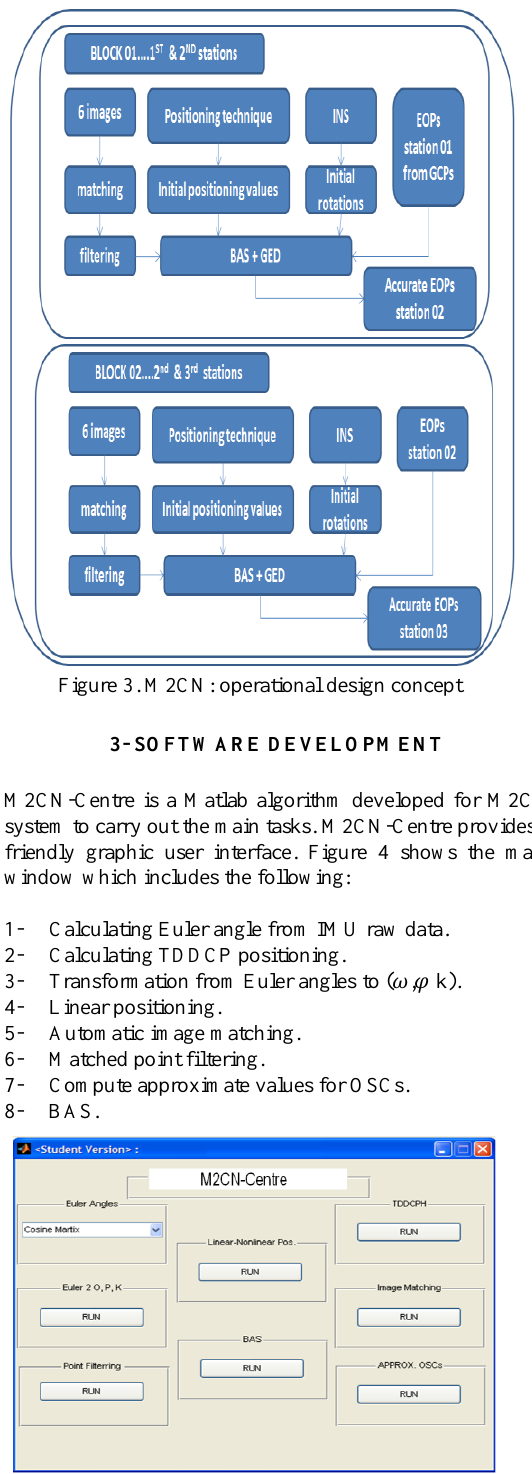
Figure 4.M2CN-Centre main user